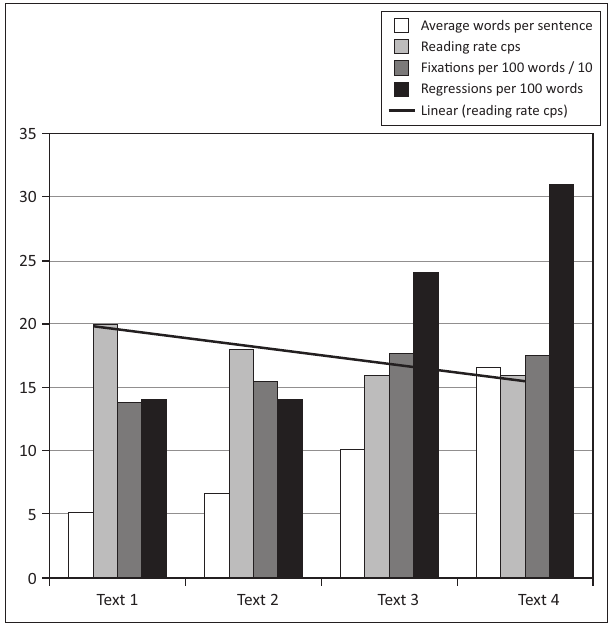
FIGURE 4: Sentence length of texts and average